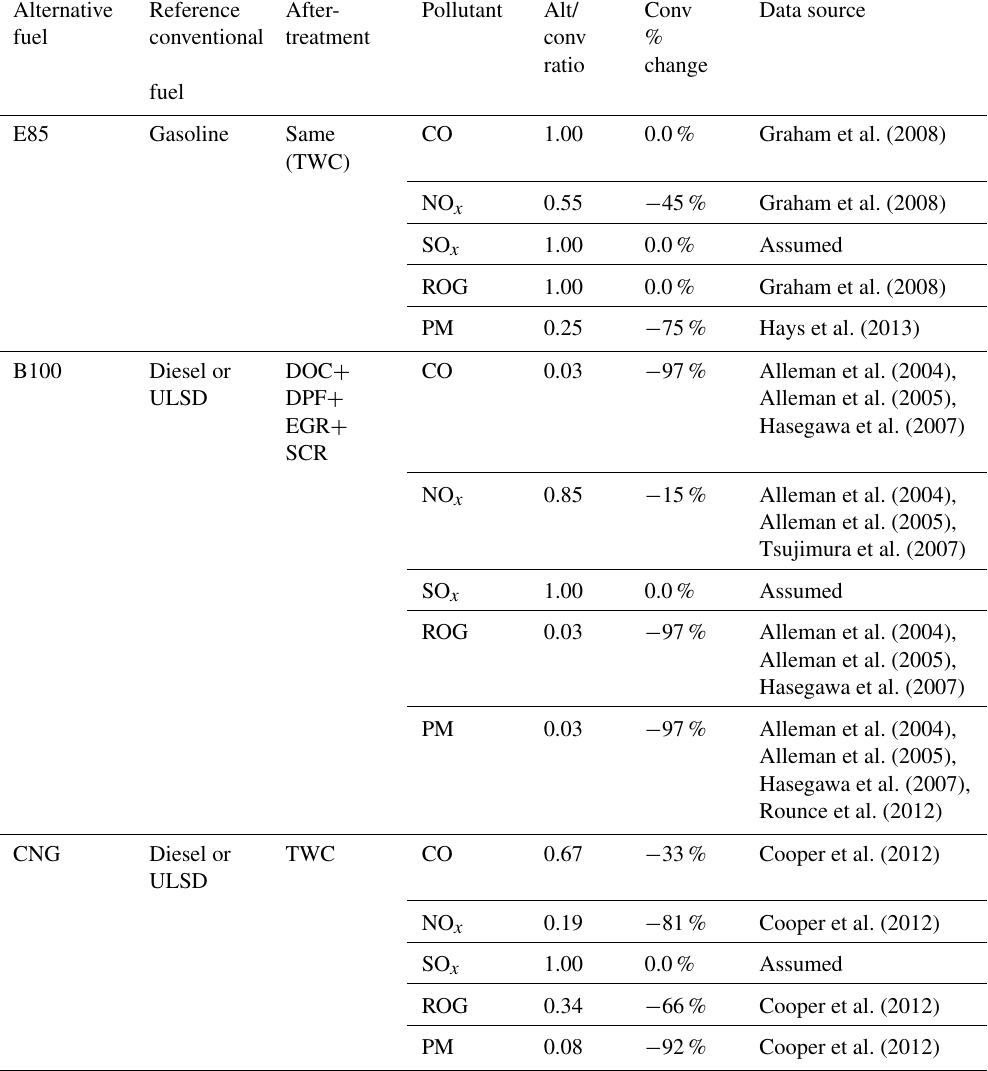
Table 1. Emissions rate changes for alternative fuels in on-road vehicles. Alternative fuels include an 85% ethanol and 15% gasoline mixture (E85), biodiesel (B100), and compressed natural gas. Conventional fuels include gasoline, diesel, or ultra-low-sulfur diesel (USLD). Aftertreatment devices include a three-way catalyst (TWC), a diesel oxidation catalyst (DOC), a diesel particle filter (DPF), exhaust gas recirculation ( EGR), and selective catalytic reduction